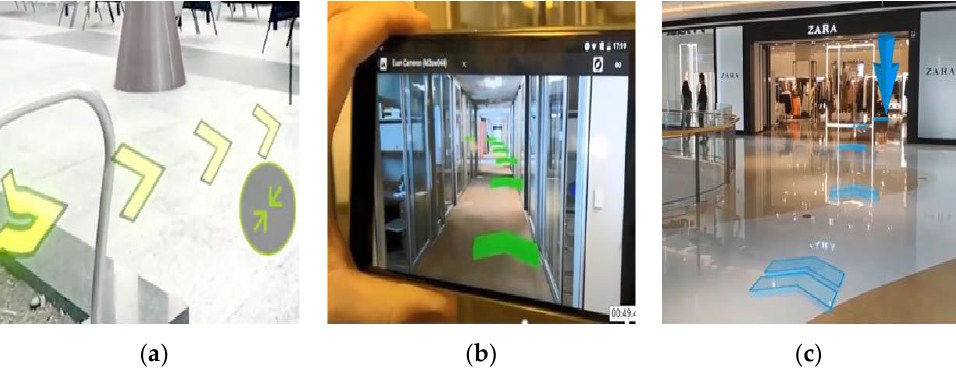
Figure 17. Comparison with the visualization of AR route navigation: ( a ) AR route navigation (Mapbox); ( b ) AR route navigation (ArcGIS); ( c ) AR route navigation (AUGL).